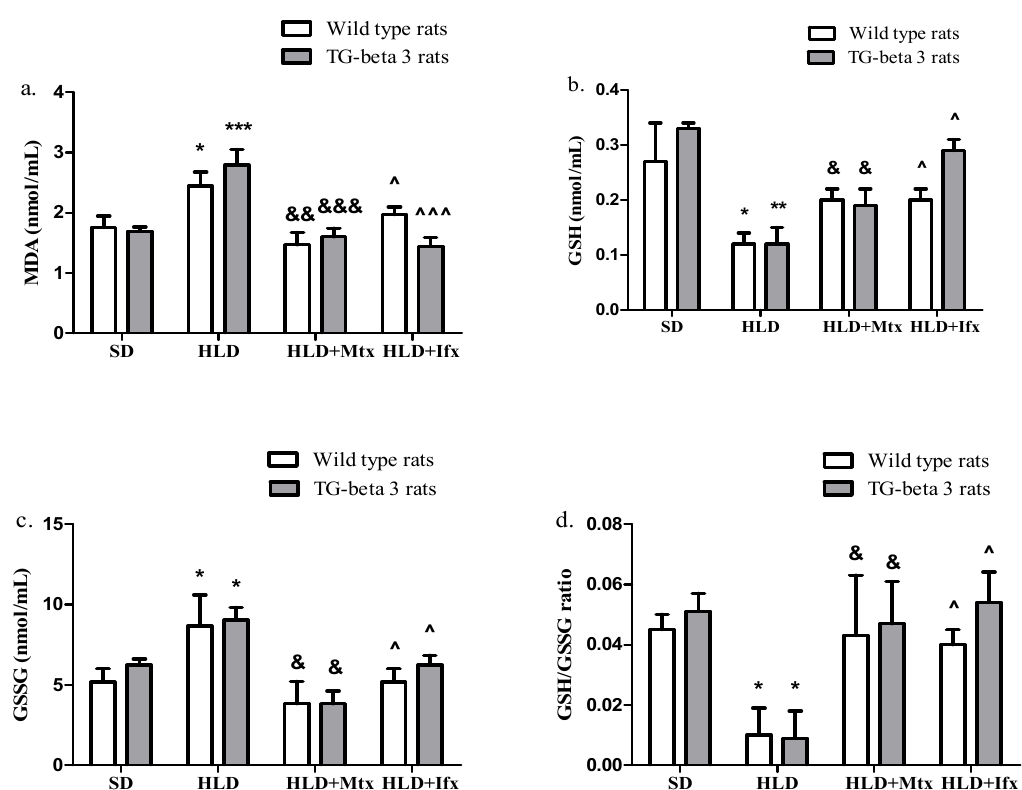
Figure 3. Methotrexate and infliximab effects on oxidative stress markers. ( a ) Malondialdehyde (MDA), ( b ) reduced glutathione (GSH); ( c ) oxidized glutathione (GSSG); ( d ) GSH/GSSG ratio. SD—standard diet; HLD—high lipid diet; Mtx-methotrexate; Ifx-infliximab; HLD + Mtx—high lipid diet associated with methotrexate; HLD + Ifx—high lipid diet associated with infliximab. * p < 0.05; ** p < 0.01; *** p < 0.001 HLD versus SD group; & p < 0.05; && p < 0.01; &&& p < 0.001 HLD + Mtx versus HLD group; ^ p < 0.05; ^^^ p < 0.001 HLD + Ifx versus HLD group.